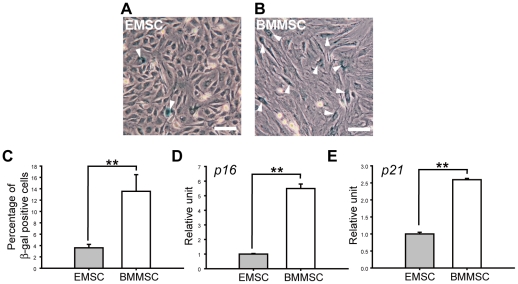
Analysis of cellular aging related markers of EMSCs and BMMSCs.(A) Determination of senescence marker, SA-β-gal, upon the fifth passage of EMSCs and (B) BMMSCs. SA-β-gal positive cells were showed as blue color and indicated by arrow heads. (C) The number of SA-β-gal positive cells was calculated from EMSCs or BMMSCs cultures. EMSCs showed lower SA-β-gal positive cells than BMMSCs (n = 4). (D) mRNA levels of cyclin-dependent kinase inhibitors p16 and (E) p21 were evaluated by qPCR. Both p16 and p21 expression levels were lower in EMSCs than BMMSCs (n = 3). All the scale bars represent 100 µm. ** represents P<0.01. Data are presented as mean ± s.d. and analyzed with Student's t-test.